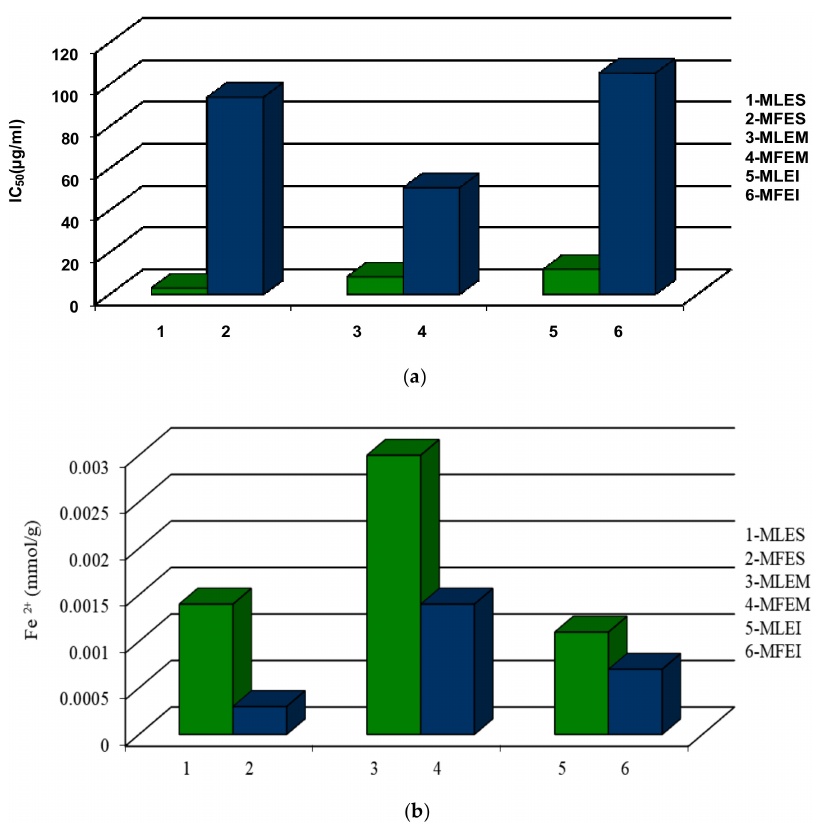
Figure 4. Antioxidant activity in the leaves and fruits extracts measured by ( a ) DPPH assay; and ( b ) FRAP